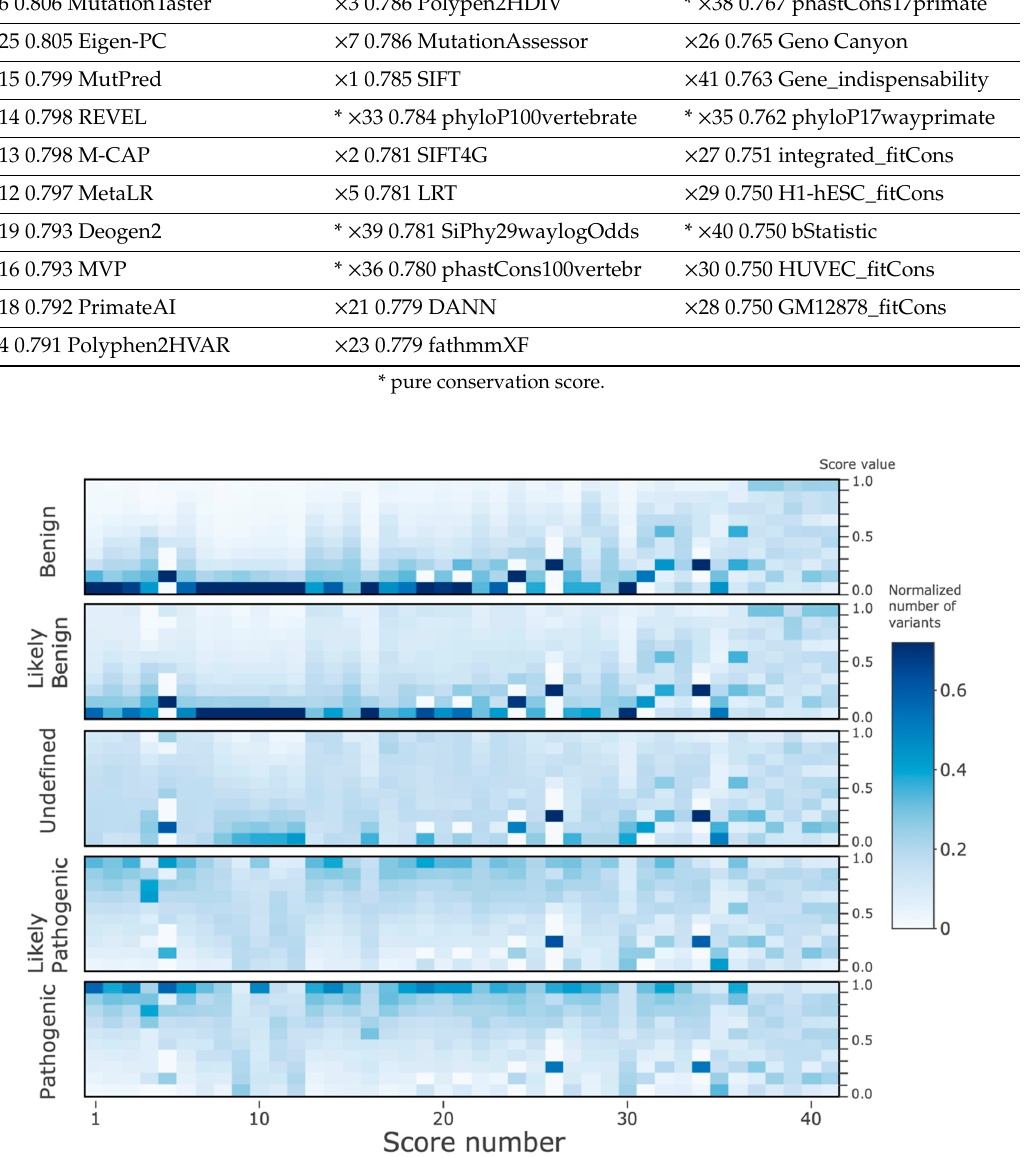
Figure 5. 2D histogram of the score values of the ClinVar dataset. The x -axis displays the 41 features, sorted from left-to-right according to decreasing r 2 as given in Table 2. The y -axis on the left side denotes the five ClinVar classes, and the Y -axis on the right corresponds to the histogram bins for the continuous values of each of 41 features (on the x -axis, 10 equally 0.1-spaced bins between 0 and 1). The colors from white (0) to blue (0.7) correspond to histogram counts (normalized to 1) in each of the bins.